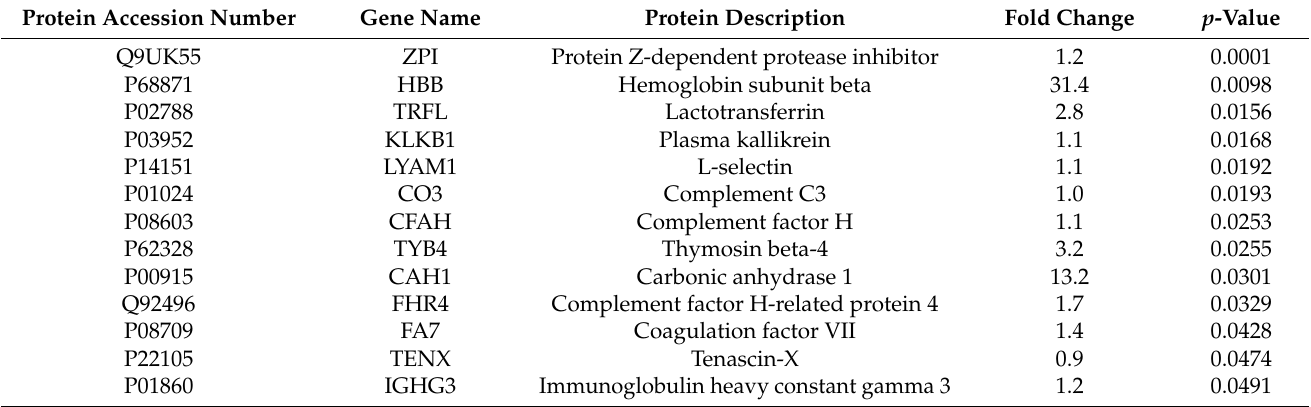
Table 2. Statistically significant de-regulated proteins between AS vs. PRGF eye drops.